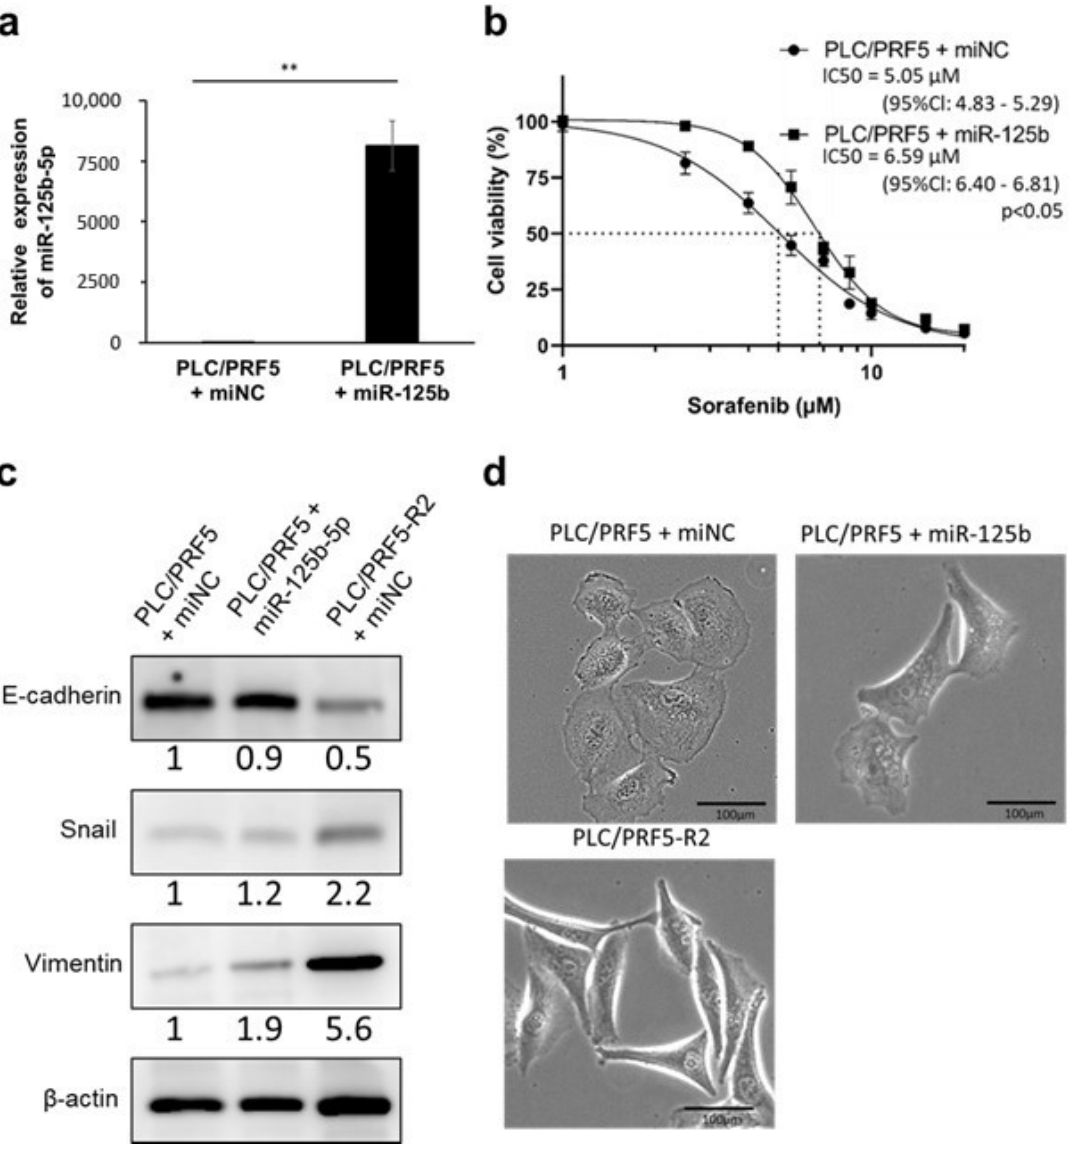
Figure 2. Forced expression of miR-125b-5p confers sorafenib resistance and epithelial-mesenchymal transition (EMT) phenotype in PLC/PRF5 cells. ( a ) The relative expression levels of miR-125b-5p in PLC/PRF5 cells transfected with miR125b-5p mimic (PLC/PRF5-miR125b) and PLC/PRF5 cells transfected with negative control miRNA (PLC/PRF5-miNC) were determined by quantitative real-time PCR (RT-PCR). ** p < 0.01. ( b ) The cell viability of PLC/PRF5-miR125b and PLC/PRF5-miNC cells treated with various concentrations of sorafenib was determined by WST assay. ( c ) Expression of EMT markers (E-cadherin, Snail, vimentin) in PLC/PRF5-miNC, PLC/PRF5-miR-125b, and PLC/PRF5-R2 cells was exam- ined by western blot analysis. Densitometry analysis indicates relative protein levels from one representative of three independent experiments. Numbers below the bands represent protein expression normalized to β -actin. ( d ) Representa- tive images of PLC/PRF5-miNC, PLC/PRF5-miR125b, and PLC/PRF5-R2 cells under observation with a stereoscopic mi- croscope are shown. Scale bars, 100 μm. In the experiments examining downregulated miRNAs, we transfected miR-192-5p, miR-194-5p, or miR-215-5p mimics in PLC/PRF5-R2 cells to determine whether these miR- NAs rescue the resistance to sorafenib. The expression levels of these three miRNAs were 2 × 10 4 to 4 × 10 4 -fold higher in PLC/PRF5-R2 cells transfected with their mimics compared with control cells, indicating high transfection efficiency (Figure S3a). However, PLC/PRF-